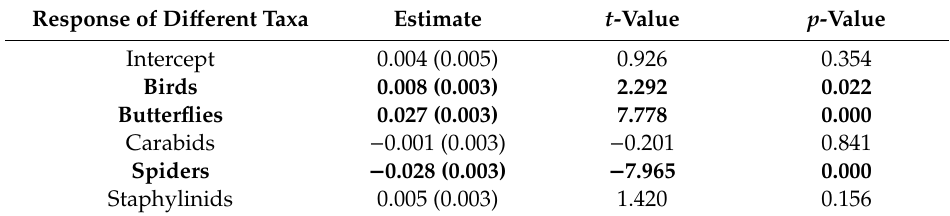
Table 1. Response of di ff erent taxa. Results of e ff ect size analysis across taxa by linear mixed e ff ect models (DF = 3281, the plot identity is taken as a random e ff ect). The baseline is provided by all taxa pooled together. The estimates (and the standard errors) of the fixed e ff ects are reported, followed by t -values and p -values. The ANOVA test of the global e ff ect of the factor variable “taxon” is significant (F = 7.768, p < 0.0001). Significant di ff erences of single taxa are shown in bold. Response of Di ff erent Taxa Estimate t -Value